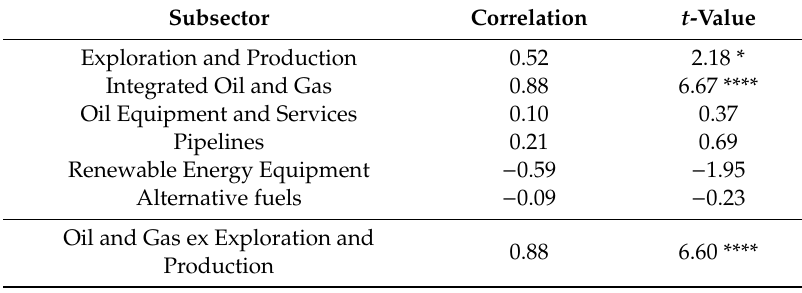
Table 9. Correlations between the Oil and Gas subsector operating cash flows and that of the GPCF, in first di ff erences. The subsectors are weighted by the FTSE GEISAC index